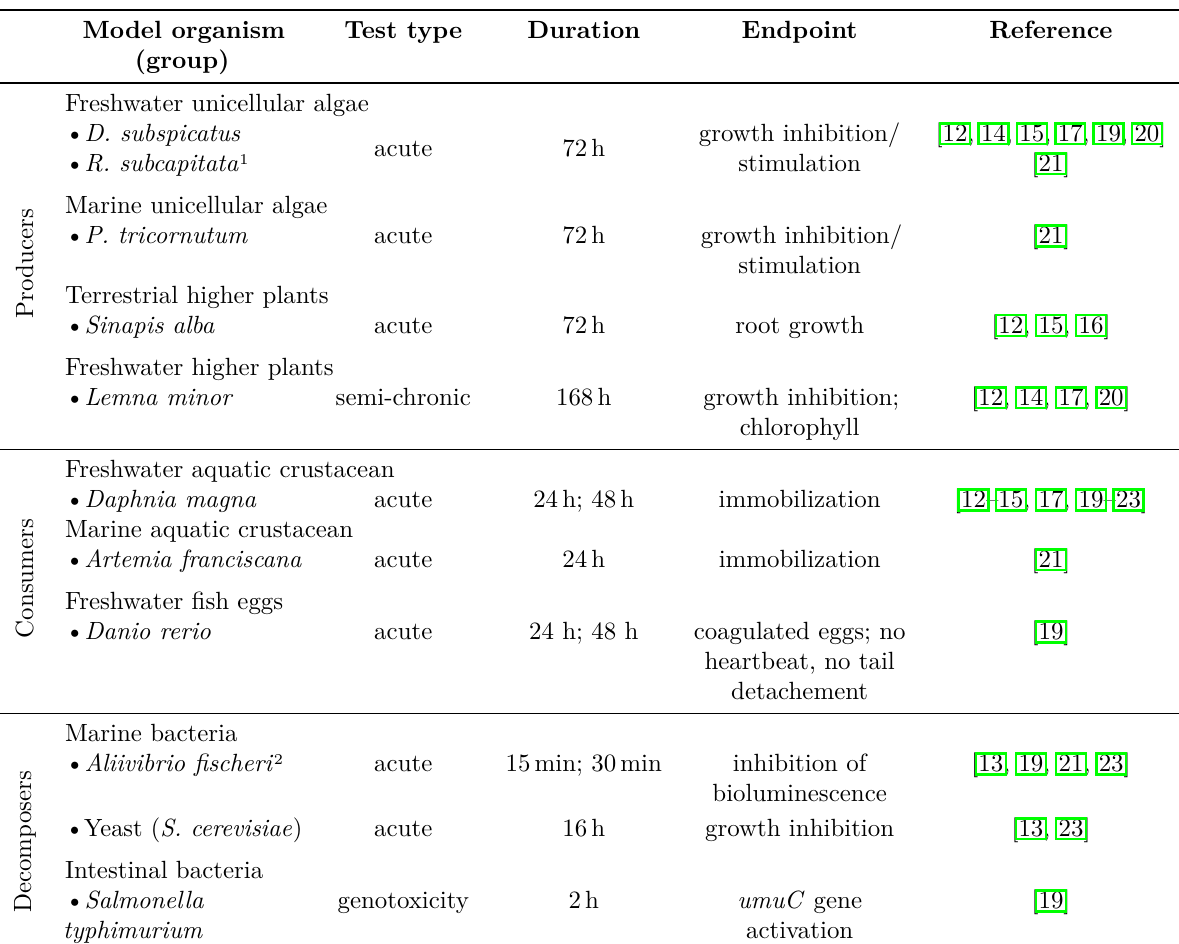
Table 2. Aquatic ecotoxicity tests performed with concrete and CDW leachate.